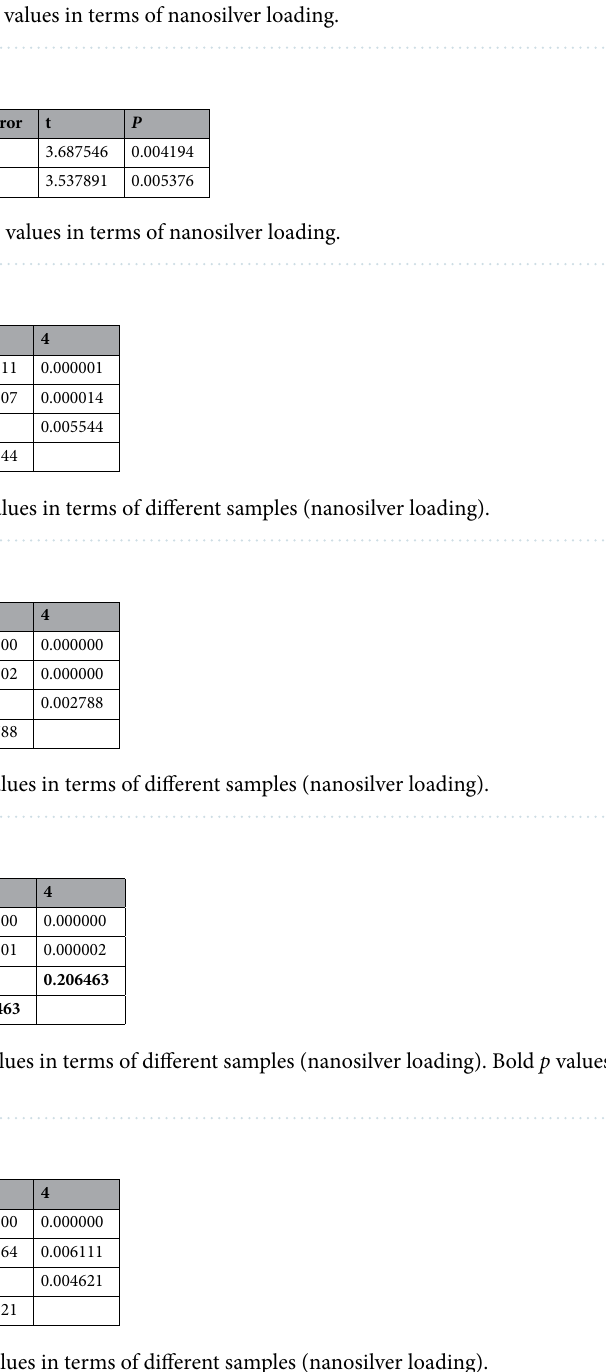
Table 12. Fisher LSD test for b* values in terms of different samples (nanosilver